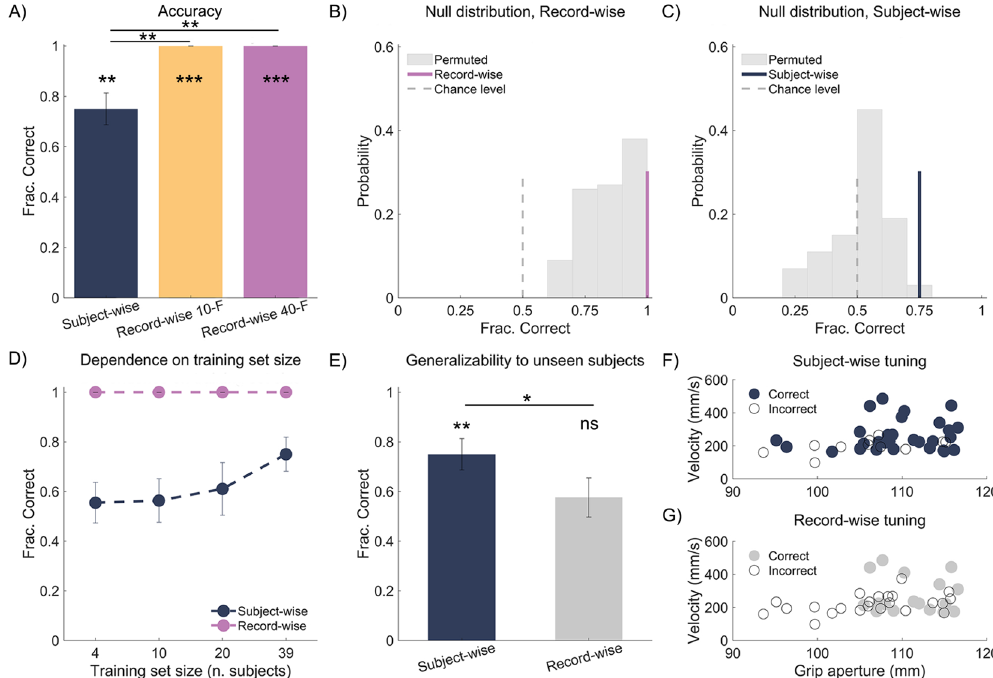
Figure 2. ( A ) Classification accuracy of group (ASD, TD) using subject-wise, record-wise 10 folds cross- validation and record-wise 40 folds cross-validation. Histograms represent mean ± SEM. ( B , C ) Permutation null distribution generated by splitting data in a record-wise fashion ( B ) or subject-wise fashion (C). The permutation null distribution is represented by the grey histograms. The purple line in ( B ) represents the observed record-wise accuracy. The dark blue line in ( C ) represents the observed subject-wise accuracy. The dashed grey line indicates the 0.5 chance level. ( D ) Group classification accuracy as a function of sample size computed using record-wise and subject-wise cross-validation. ( E ) Group classification accuracy of unseen subjects obtained using subject-wise hyper-parameter tuning and record-wise hyper-parameter tuning. ( F , G ) Movement data colored according to group classification of one exemplar unseen subject with ASD using subject-wise hyper-parameter tuning ( F ) and record-wise hyper-parameter tuning ( G ). Data are visualized as a scatterplot of velocity at 80% of movement duration and grip aperture at 90% of movement